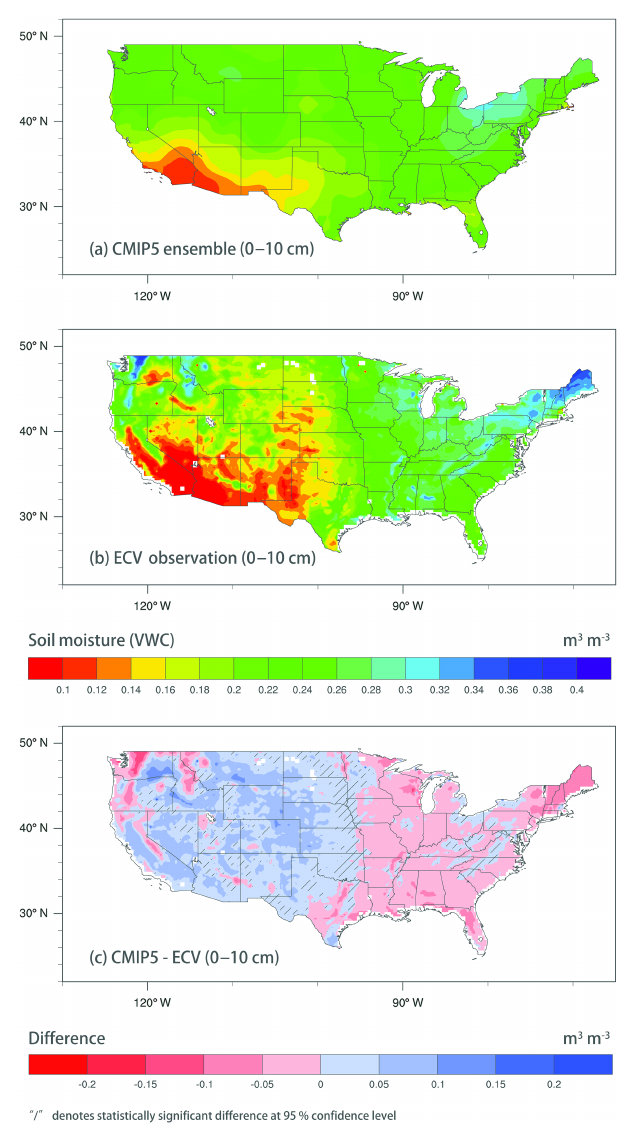
Figure 5. Same as Fig. 4, except it compares the mean soil mois- ture (m 3 m − 3 ) over CONUS (2003–2012) during the warm season (April to September) from the CMIP5 ensemble with the satellite- derived ECV soil